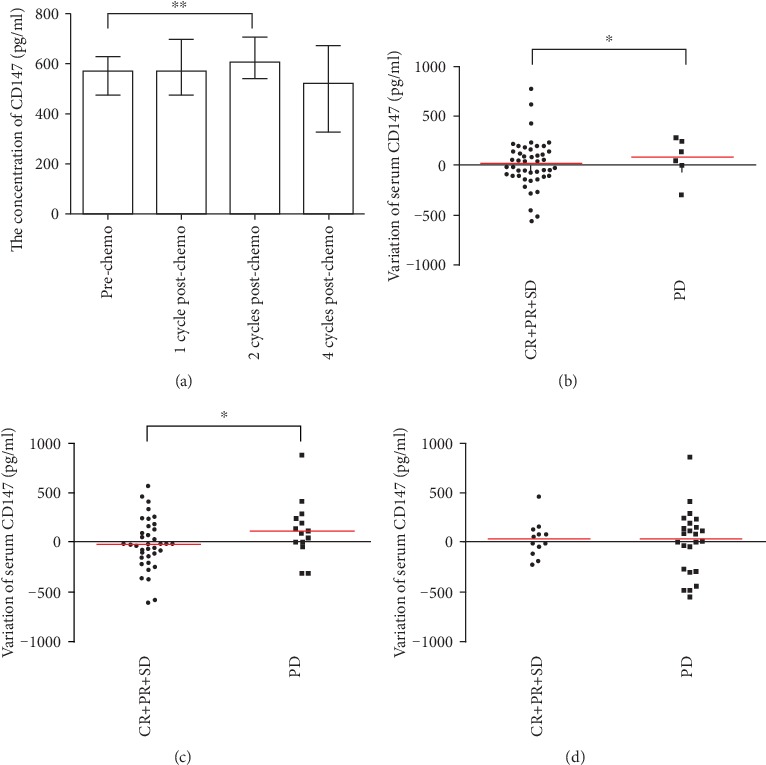
(a) Compared with baseline, serum concentrations of CD147 increased gradually after the first and second chemotherapy cycles and then decreased after the fourth cycle in patients with NSCLC. (b) Association between the changes in serum concentrations of CD147 from baseline to the first chemotherapy cycle and tumor response after the first chemotherapy cycle. (c) Association between the variation in serum concentrations of CD147 from the first to second chemotherapy cycle and tumor response after the second chemotherapy cycle. (d) Association between the alterations in serum concentrations of CD147 from the second to fourth chemotherapy cycle and tumor response evaluated after the fourth chemotherapy cycle. Each dot represents a patient, and red lines represent median values. CR: complete response; PR: partial response; SD: stable disease; PD: progressive disease. ∗∗P < 0.01 and ∗P < 0.05.